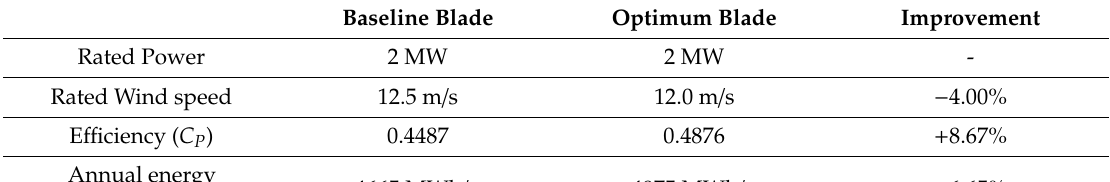
Figure 10. Power efficiency comparison between the optimal and baseline blades.